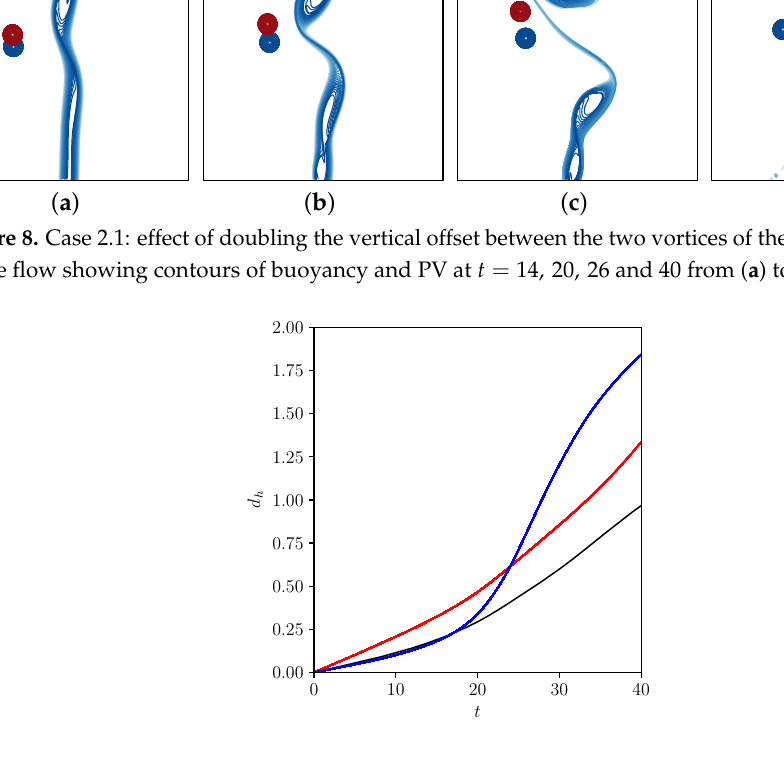
( b ) d ( d 2 + δ 2 ) 3/2 vs d h / h